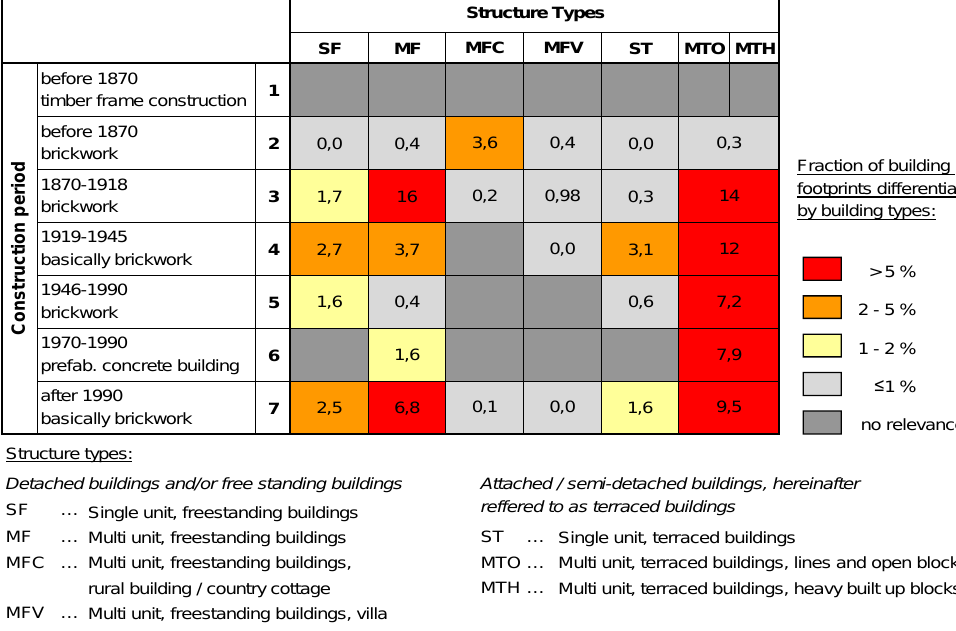
Fig. 8. Percentage of building footprints of the residential buildings added up to building types in the study area.